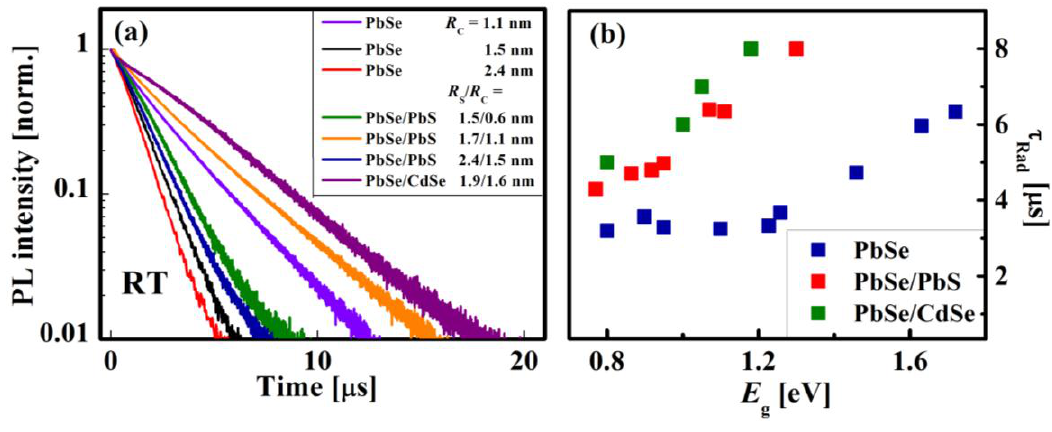
Figure 19. ( a ) Representative RT PL decay curves for QDs of different composition, R C , and R S /R C ratios (see the legend); ( b ) dependence of radiative life-time, τ Rad , on the size and composition of the QDs listed in the